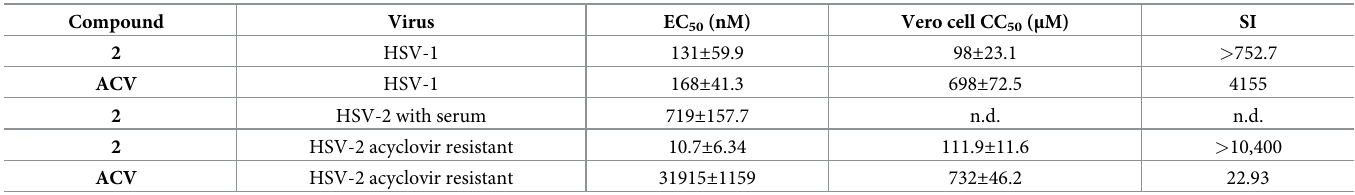
Table 3. Antiviral activity of compound 2 on Vero cell line infected with HSV-1, HSV-2 with serum and HSV-2 acyclovir resistant strains.